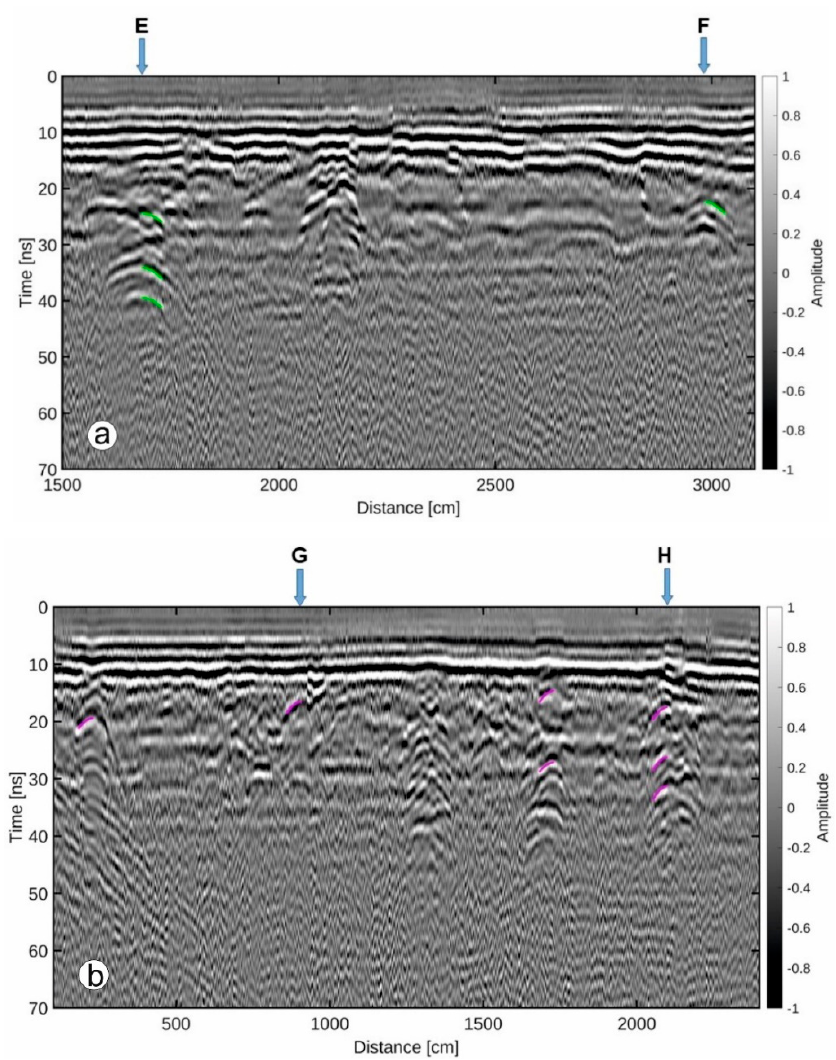
Figure 6. ( a ) GPR section of the L74 Line containing the right arm (plotted in green) of the hyperbolae whose ( t 0 ,Vs ) parameters are picked in the coherency panels of Figure 7a for the location E, and Figure 7b for the location F; we decided to fit the right arm of the misshapen hyperbola at 34 ns in E because it appears more regular. ( b ) GPR section of the L92 Line. In this case, the left arms (plotted in magenta) of the hyperbolae are displayed. Their ( t 0 ,Vs ) parameters are picked on the coherency panels of Figure 7c for location G and Figure 7d for location H. The other magenta half-hyperbolae on the L92 Line correspond to additional positions where the velocity analysis has been carried out.